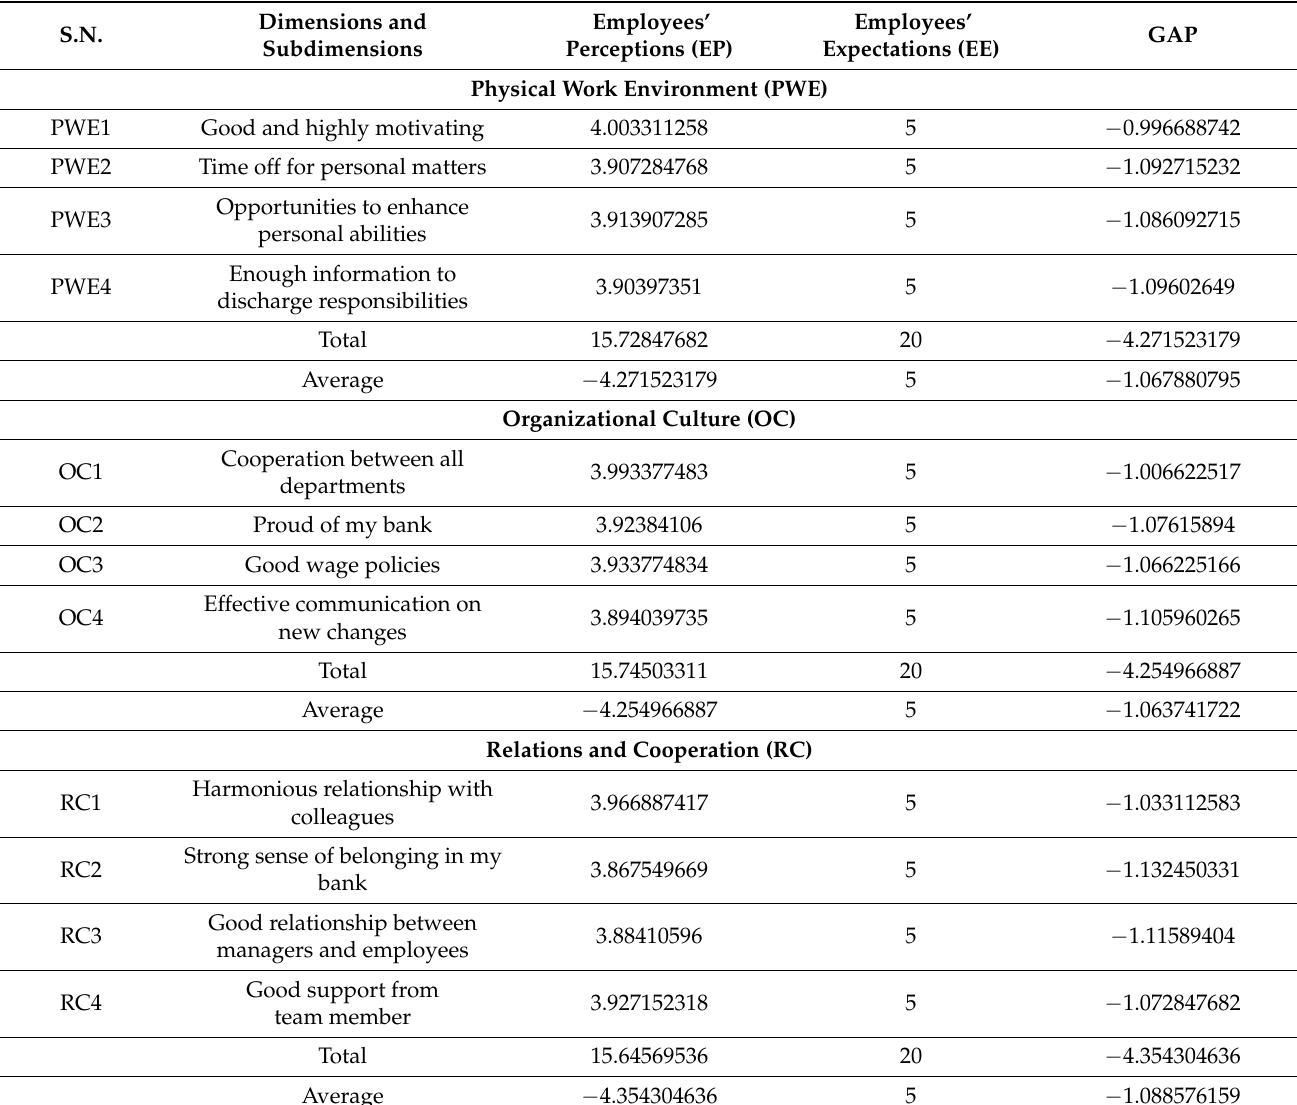
Table 5. Gaps in the quality of work life (GQWL) in all dimensions and subdimensions of QWL (all